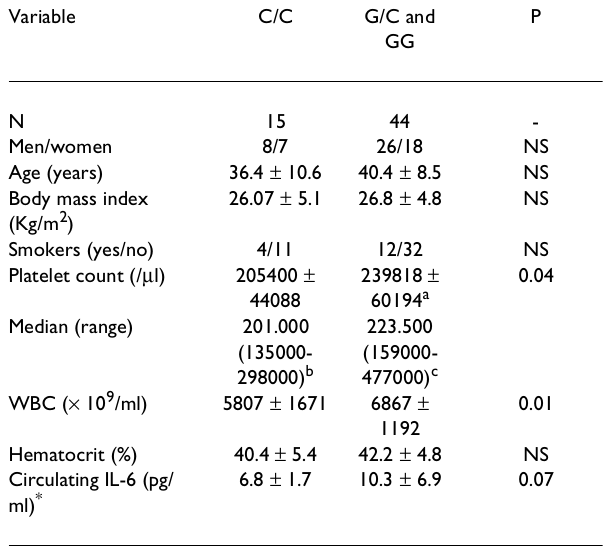
Table 1: General characteristics of the Study